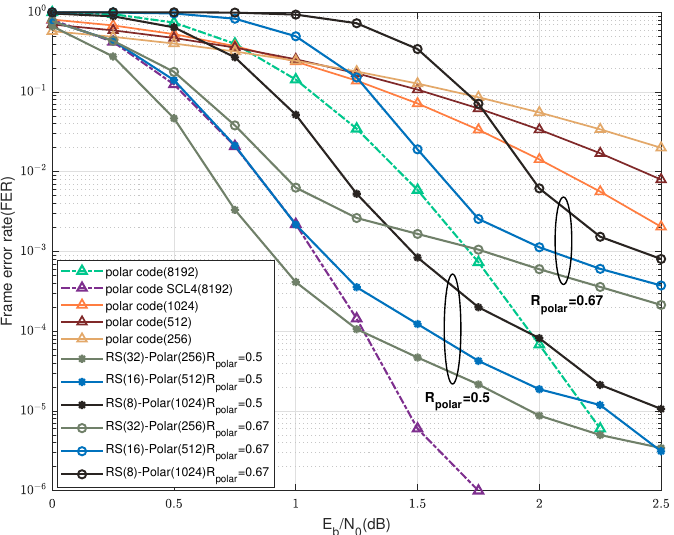
Figure 6. Performance comparison of the UEP-RS-polar product codes, the SC decoding and SCL decoding of long polar codewords over AWGN channels when R tx ≈ 1/4 and R polar = 0.5,0.67.